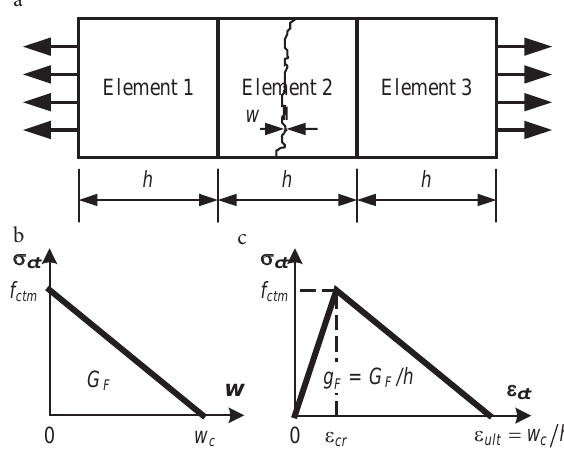
Fig. 1. Concrete element subjected to tension (a); stress-crack width model (b) and average stress-strain model (c) (Gribniak et al.